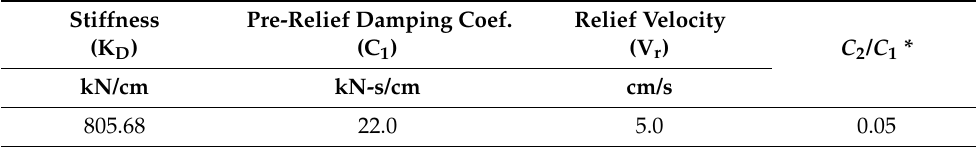
Table 2. Technical parameters of the supplemental story-equivalent oil